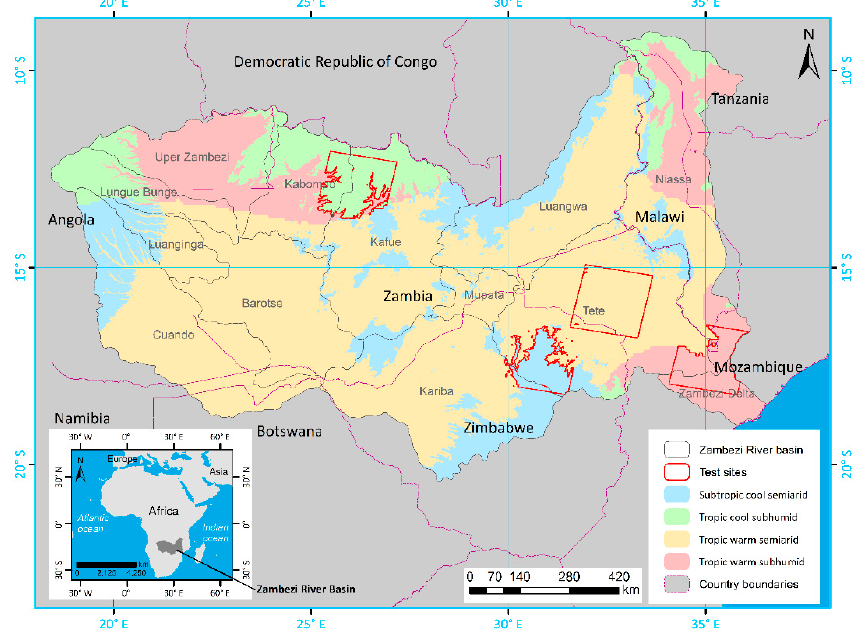
Figure 1. Map of the Zambezi River basin showing the four different agroecological zones (AEZ) and the test sites (with red boundaries) at each AEZ (Adapted from [34]).